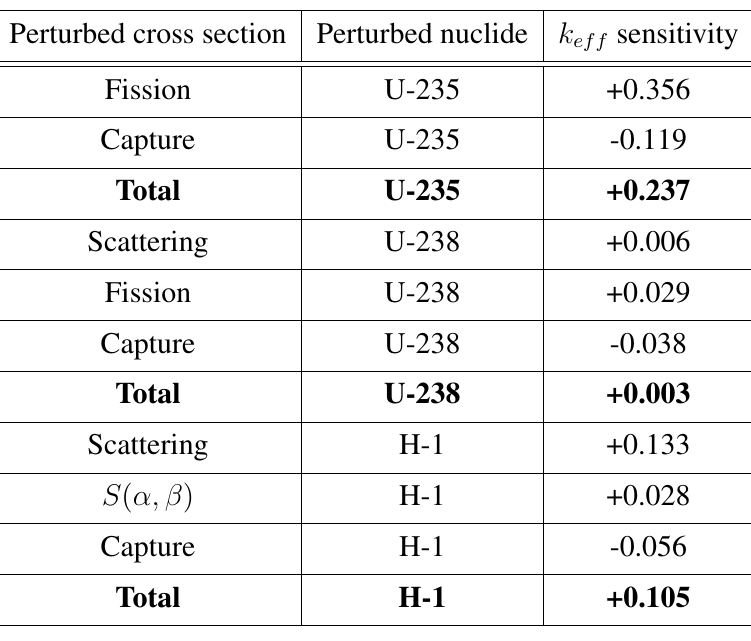
Table 1: k sensitivity coefficients to perturbations in fuel material cross eff